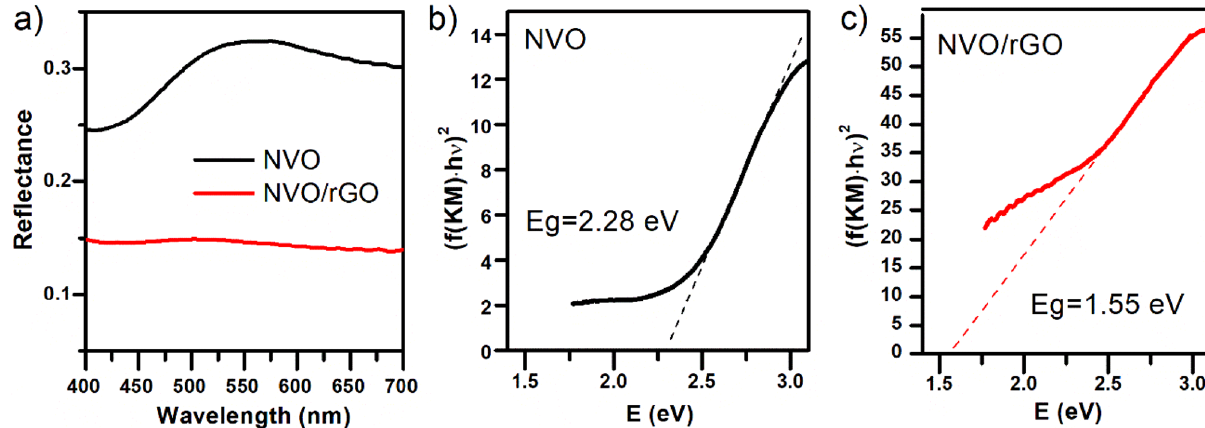
Figure 3. Optical properties of NVO and NVO/rGO: Reflectance spectra ( a ) and the (f(KM)·hν) 2 vs hν plots resulting from the UV ‒ Vis reflectance spectra with corresponding energy band gaps for NVO ( b ) and NVO/ rGO ( c